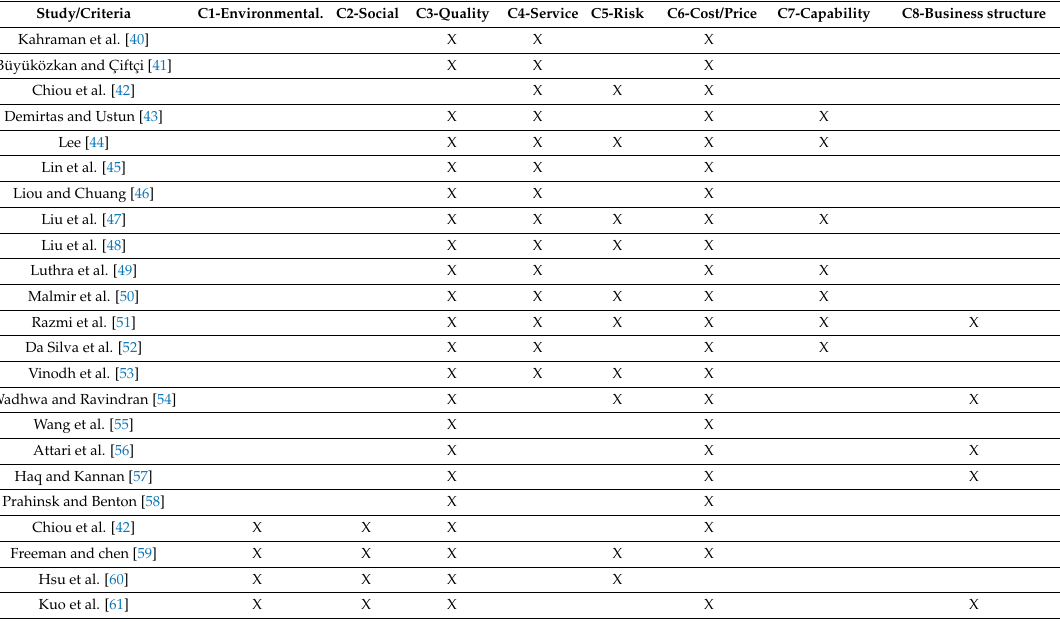
Table 1. The used criteria in literature for supplier